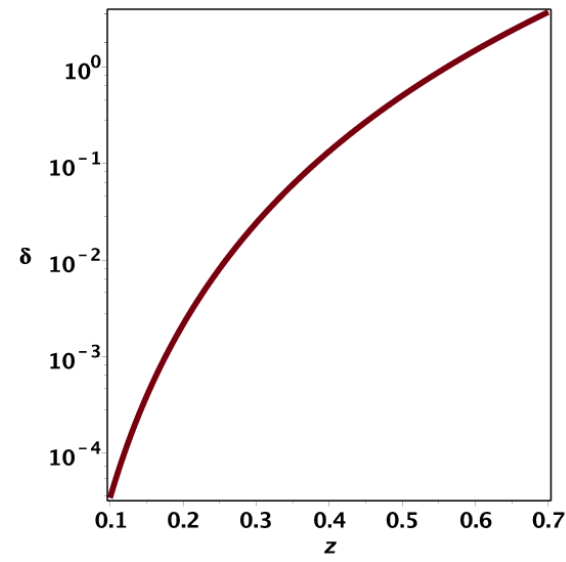
Figure 1. Percentage error, δ , relative to the Taylor approximated luminosity distance (see Equation (18)) when H 0 69.6 kms (cid:1) 1 Mpc (cid:1) 1 and Ω M (cid:16) (cid:16)